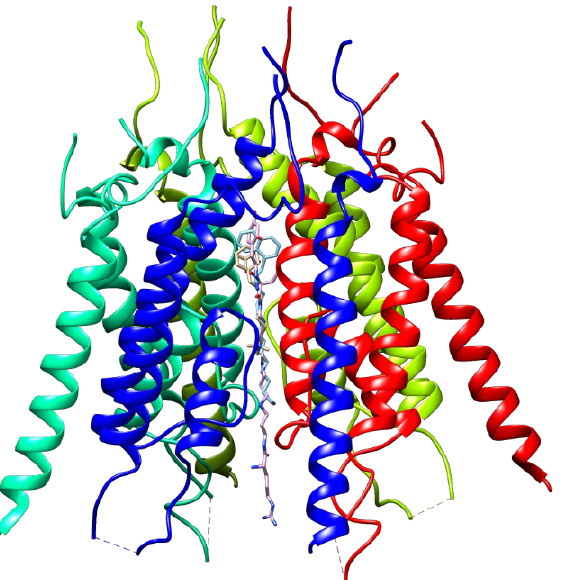
Figure 12. Binding modes of the AMPA receptor ion channel blockers IEM-1460 ( 83 , beige, PDB: 6DM0), NASPM ( 80 , cyan, PDB: 6DM1), and AgTx-636 ( 78 , pink, PDB: 6O9G) in the ion channel pore of GluA2 TMD. For clarity, among the aligned receptor subunits, only the subunits for the IEM-1460 structure are shown in blue, mint, spring green, and red.